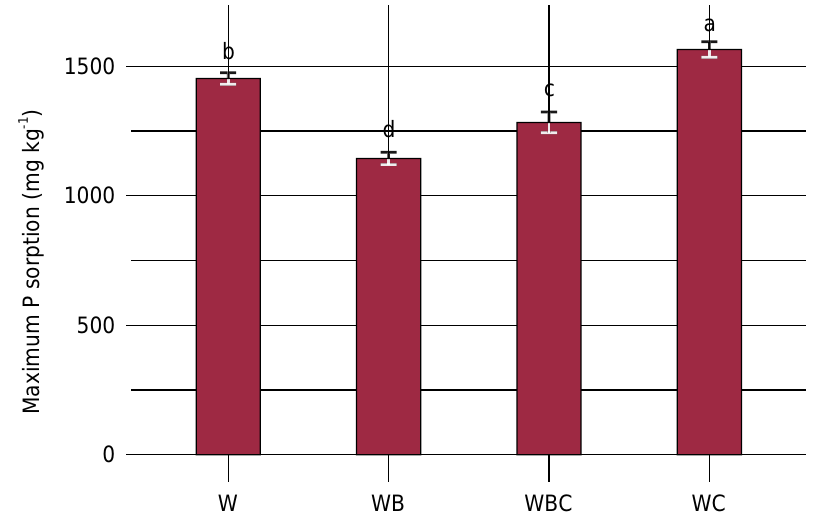
Figure 6. Maximum P sorption capacity in mining waste (W) treated with organic compost (WC) and biochar (WB) alone and in combination (WBC). Means followed by the same letter do not differ by Tukey’s test